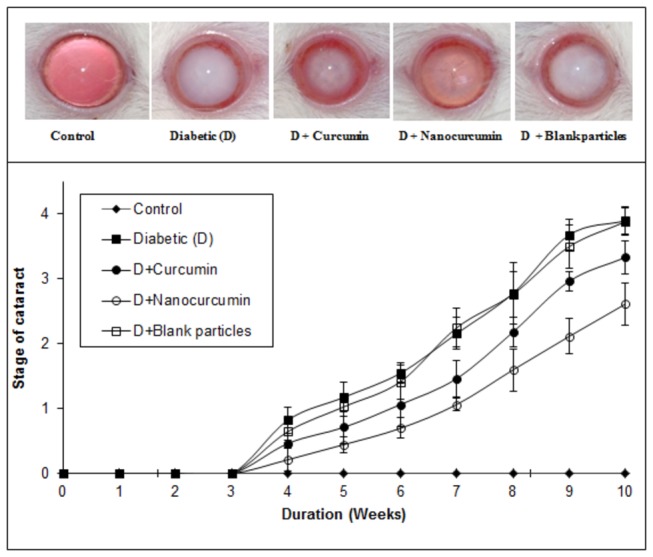
The effect of curcumin and nanocurcumin on STZ-induced cataract in rats.
Top
panel: Representative photographs of lens from each group at the end of 10 weeks. Bottom
panel: Quantitative representation of cataract progression in each group with time. Stage of cataract in each group was averaged at a given time and the average stage of cataract along with standard error was plotted as a function of time.